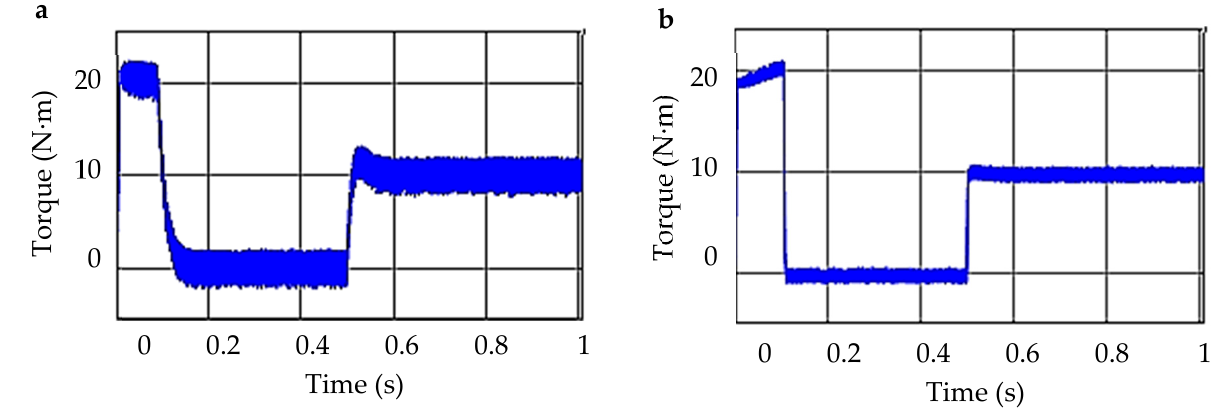
Figure 12. Electromagnetic torque under load during startup and steady state.